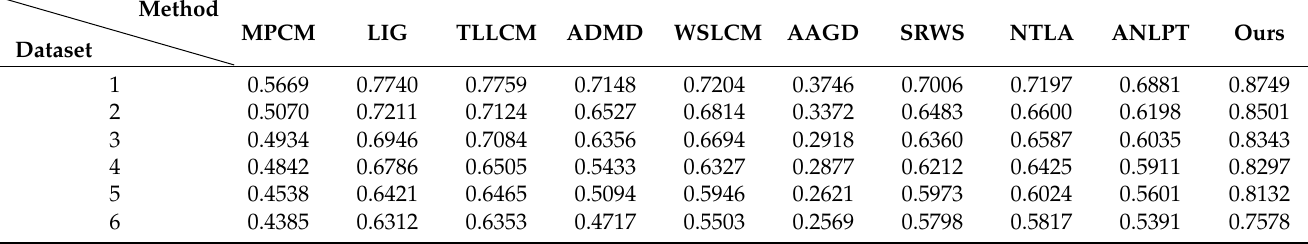
Figure 16. Resulting diagrams from the comparison experiment: AAGD, ADMD, and ANLPT. Table 12. AUC of different methods with real